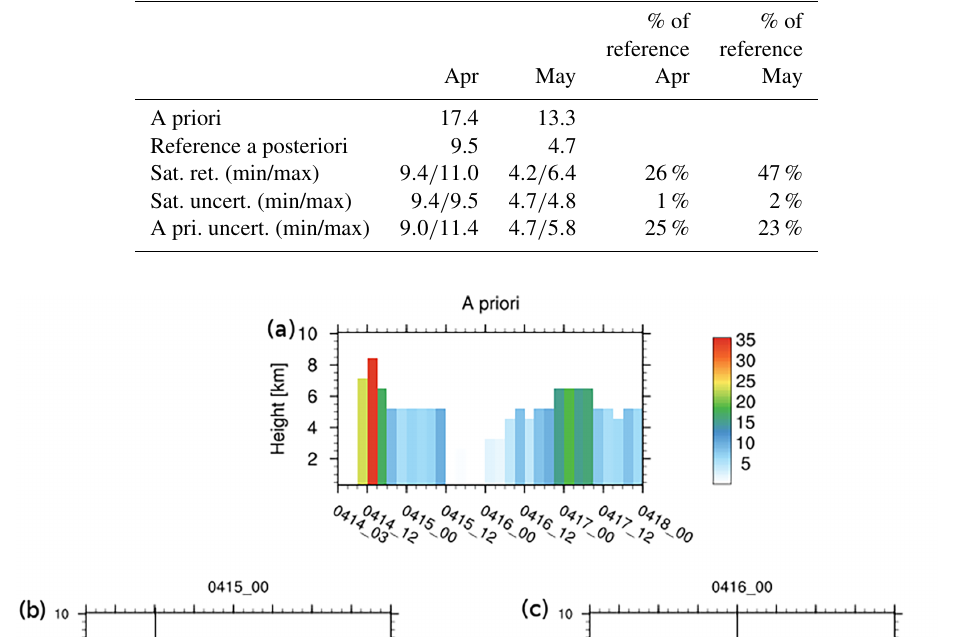
Table 1. Total fine-ash emissions in Tg over the April and May period for the a priori estimate and the reference a posteriori with the satellite retrieval with 1.75 geometric standard deviation, 100% uncertainty in the satellite data, and 75% uncertainty of the a priori emission. Below are shown the minimum and maximum a posteriori results by only changing the satellite retrieval, satellite mass load uncertainty, and a priori uncertainty while keeping the other uncertainties at reference levels. The spread between maximum and minimum is also given as a percentage of the reference.